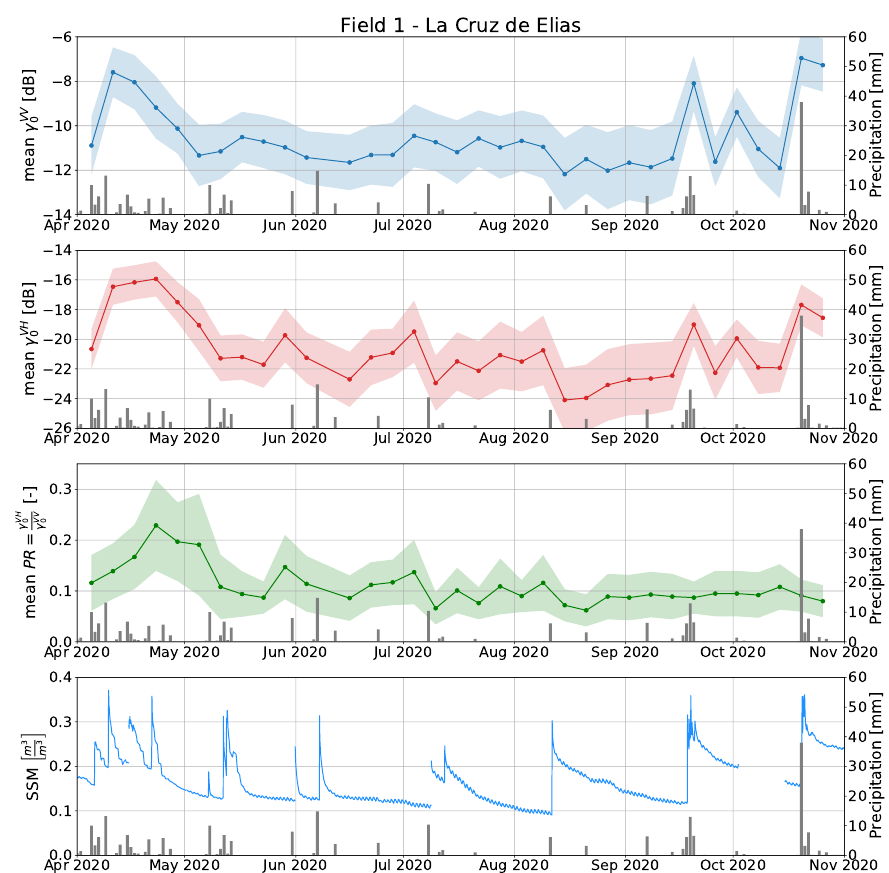
Figure 5. Time series of mean SAR parameters over field 1 of La Cruz de Elias and in situ data registered from the stations. The time series from April to October 2020 is reported. γ V V 0 in dB is represented in blue, γ V H 0 in dB is illustrated in red, PR is described with a green line, in situ soil moisture in m 3 /m 3 are shown with a light blue line and finally, the precipitations in mm are reported with gray bars. The shadows in the SAR parameters graphs represent the standard deviation over the field 1 for every